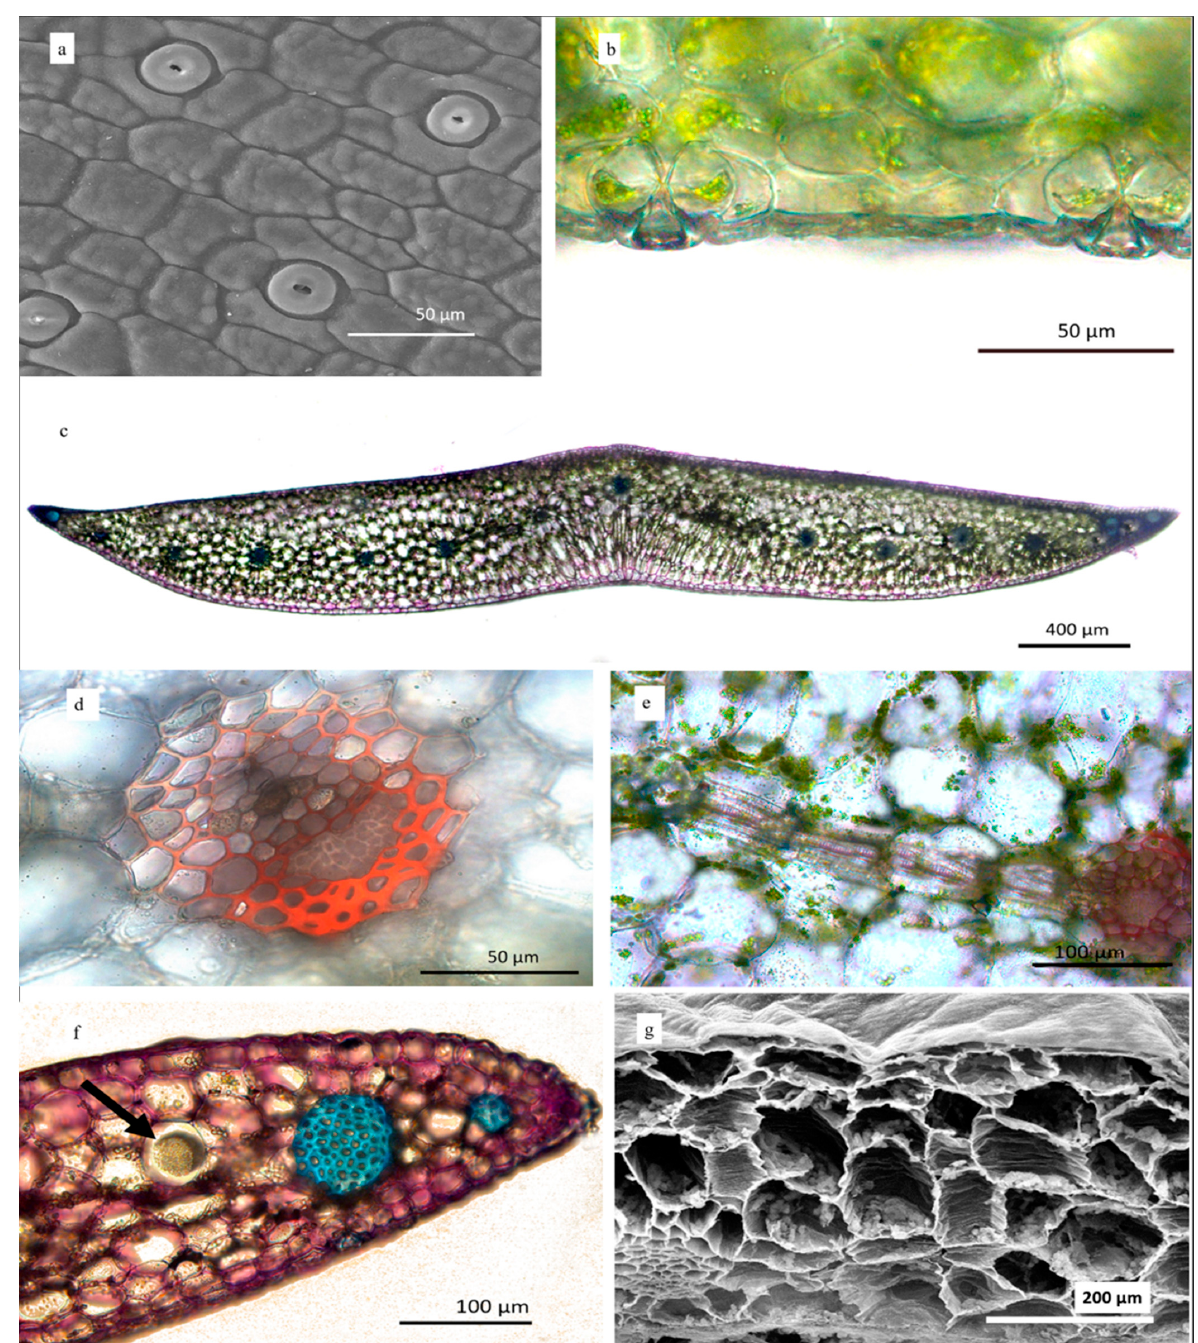
Figure 4. Leaf anatomy of Cattleya purpurata seedlings. Representative seedlings obtained on M551 medium were selected for images. ( a ) SEM picture of the lower surface of the leaf, revealing hexagonal cells covered by a thick granular cuticle and the tetracytic stomatal apparatus with C-shaped guard cells; ( b ) transversal section: detail of the leaf’s abaxial portion, in which stomata are visible. Cuticle is 6–9 μ m thick; ( c ) transversal section stained with TBO. Seven vascular bundles arranged in a row are visible. The central midvein is positioned near the lower surface. A dorsiventral mesophyll is present at the level of the central midvein, while a homogeneous one is distinguishable towards the margins. Two sclerenchymatic bundles are present at each leaf tip; ( d ) View of the central midvein stained with HCl-phloroglucinol; ( e ) transversely developed vessel elements, connecting with a vascular bundle red-stained with HCl-phloroglucinol; ( f ) transversal section of the leaf stained with TBO. The two sclerenchymatic bundles are visible near the leaf margin; ( g ) SEM picture of the mesophyll in cross section: banded thickenings are distinguishable in some cells.